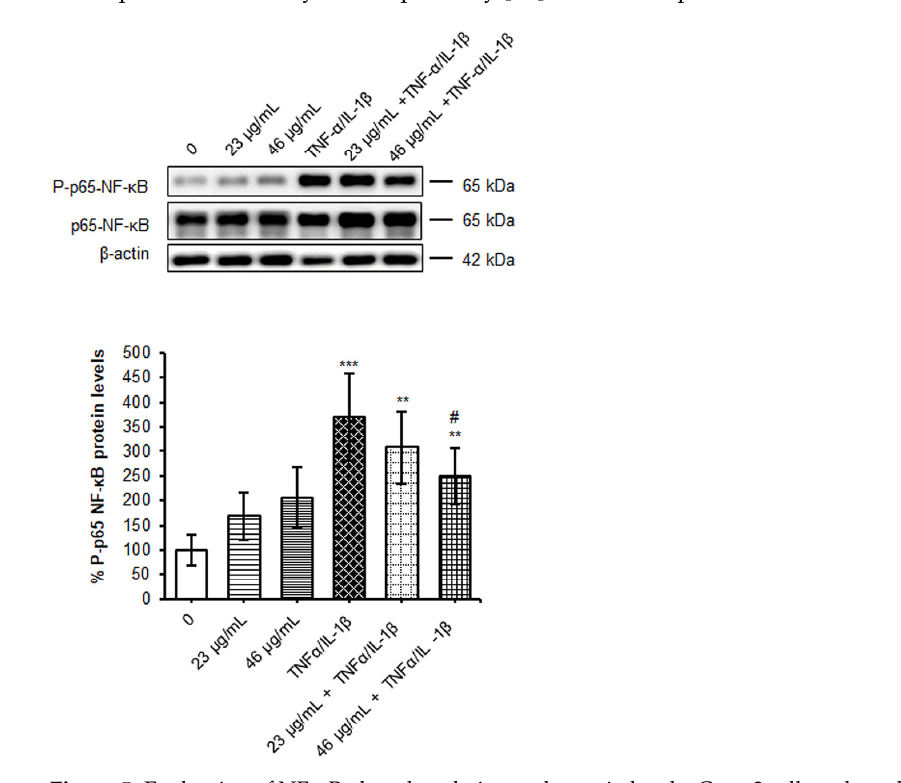
Figure 5. Evaluation of NF ‐κ B phosphorylation and protein levels. Caco ‐ 2 cells, cultured